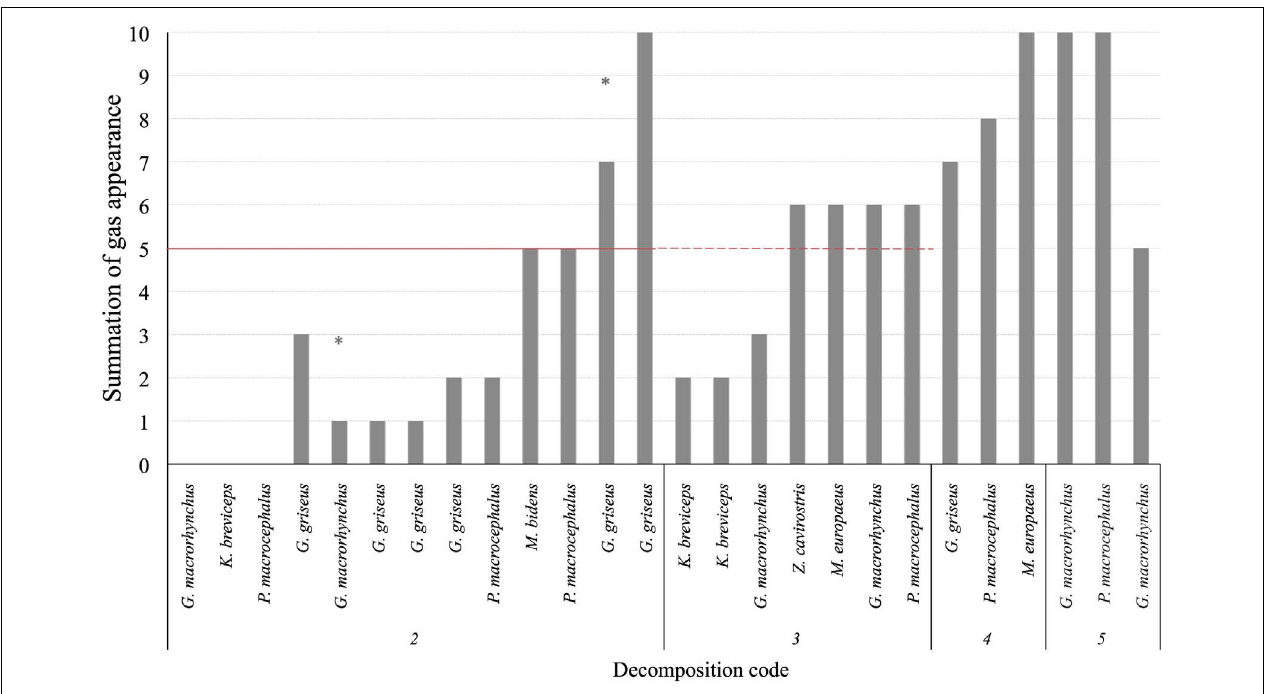
localization was not adequately observed for bubbles.The red line is presented at half of the total gas score (5 of 10) in order to better illustrate the total gas scores of animals that fall above and bellow the